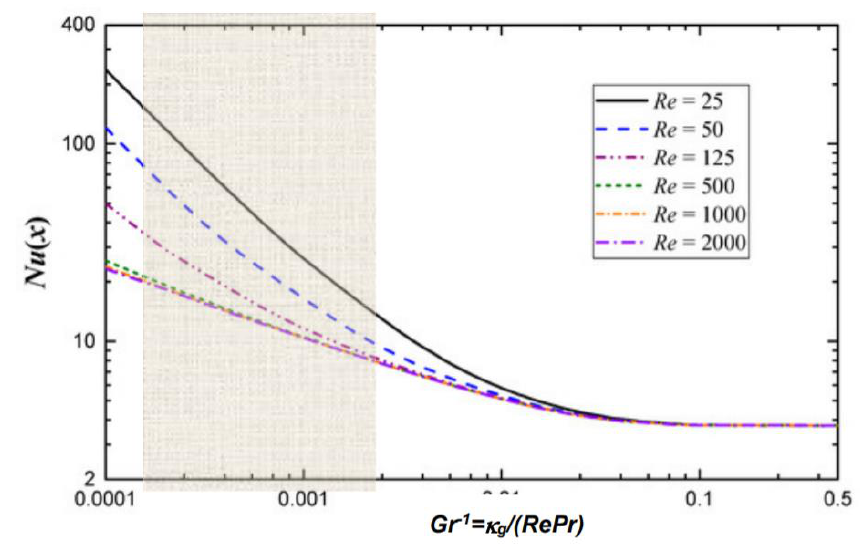
Figure 5. Nusselt number vs. Graetz number.